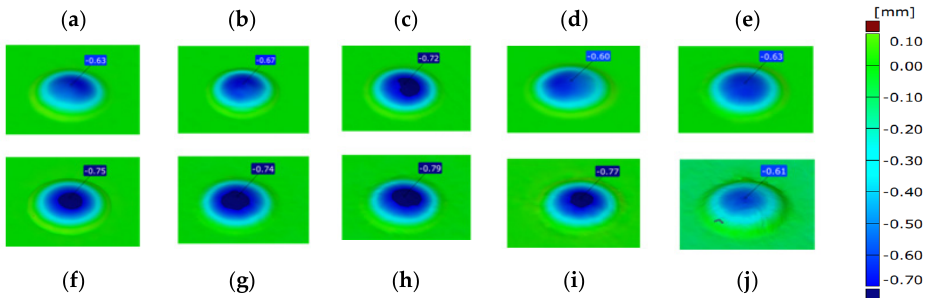
Figure 8. Results of 3D scanning of the punch calotte after the increasing number of produced forgings: ( a ) 62, ( b ) 420, ( c ) 600, ( d ) 620, ( e ) 700, ( f ) 1320, ( g ) 2100, ( h ) 2320, ( i ) 2660, ( j ) 3000 items.